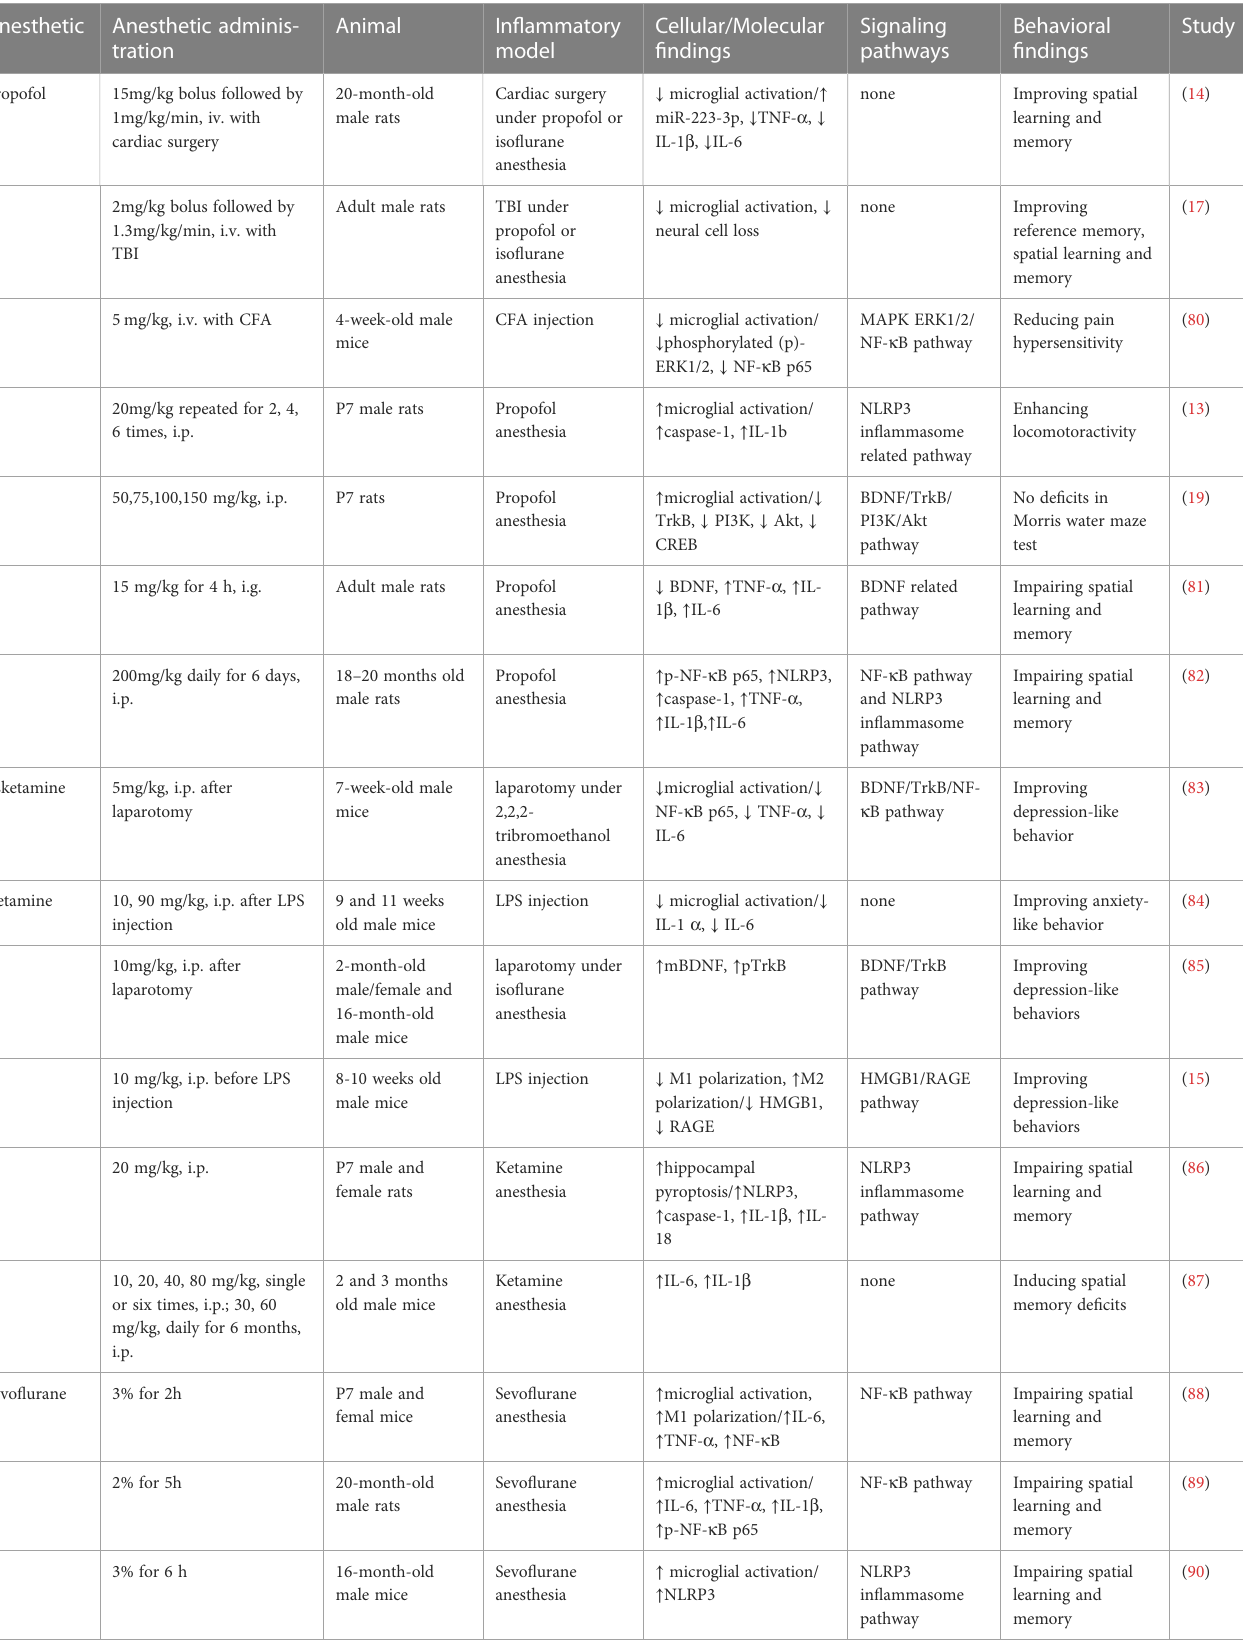
TABLE 1 Effects of anesthetics on microglia and related signaling pathways in vivo . Anesthetic Anesthetic adminis- Animal In fl ammatory tration model Propofol 15mg/kg bolus followed by 1mg/kg/min, iv. with cardiac